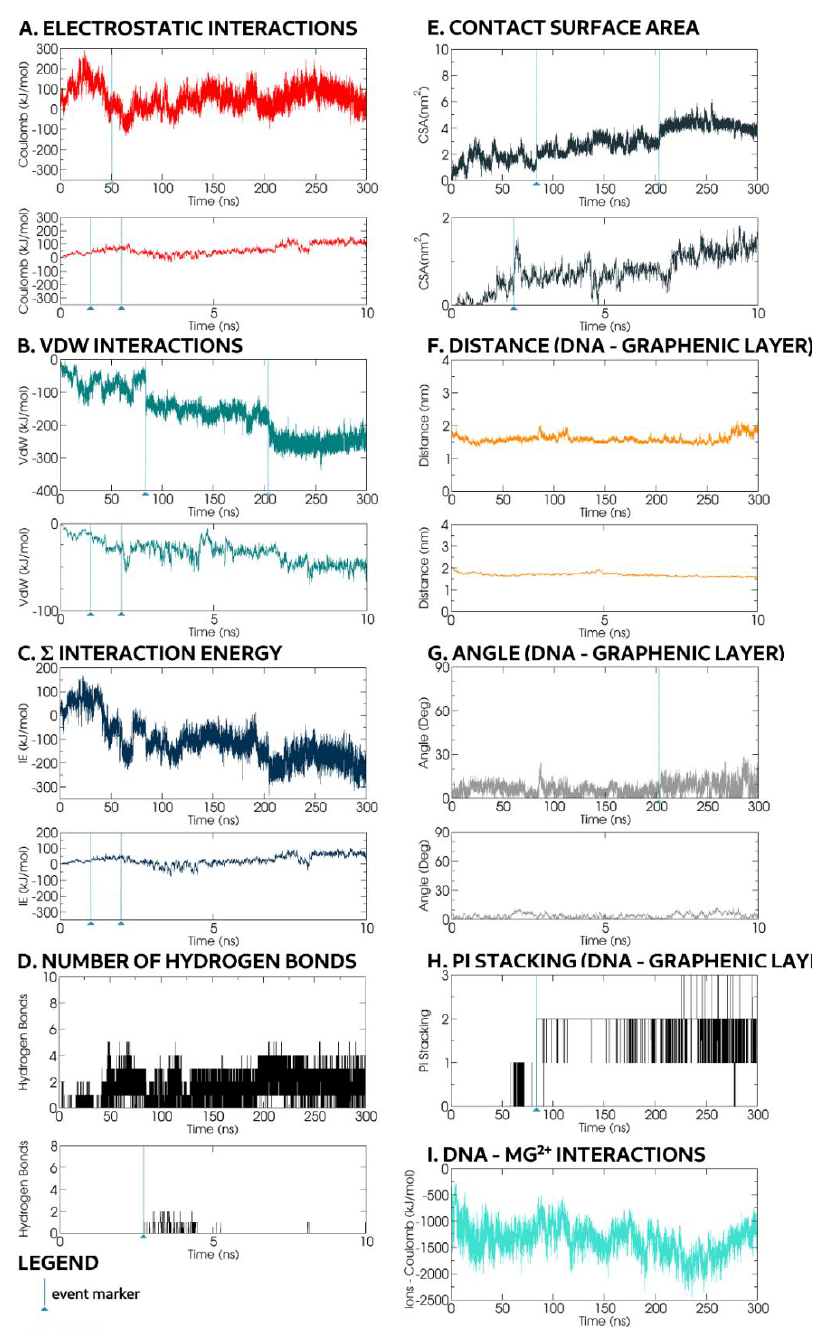
Figure 8. Evolution of di ff erent parameters over the 300ns simulation time: ( A ) Electrostatic interactions between GO and dsDNA; ( B ) VdW interactions between GO and dsDNA; ( C ) Interaction energy between GO and dsDNA; ( D ) Hydrogen bonds formed between GO and dsDNA; ( E ) Contact surface area between GO and dsDNA; ( F ) Distance between the dsDNA molecule and the graphene layer; ( G ) Angle between the dsDNA molecule and the graphenic layer; ( H ) π – π stacking between dsDNA and the graphenic layer; ( I ) Electrostatic interactions between the dsDNA molecules and Mg 2 + ions within 1.4 nm of both the dsDNA and the GO.